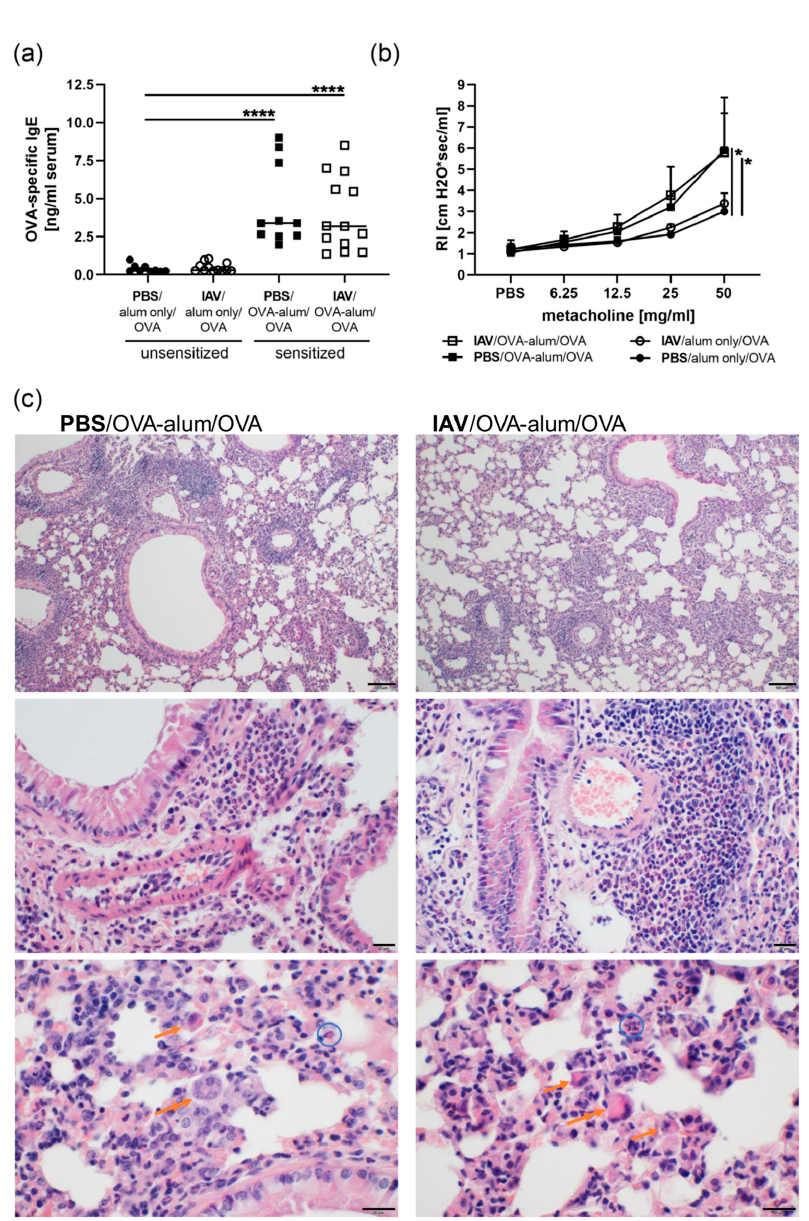
Figure 4. Resolved IAV infection does not affect IgE production and airway hyperreactivity but affects histological changes in AAI. Mice were infected i.n. with a sublethal dose of IAV or treated with PBS on day 0, were sensitized against OVA i.p or mock-sensitized with alum only i.p. on days 14, 21 and 28 and all mice were challenged i.n. with OVA on days 35, 36 and 37. On day 39 post infection, OVA-specific IgE levels in the serum ( a ), airway hyperreactivity in terms of lung resistance (RI) in response to metacholine ( b ) and histological changes in hematoxylin and eosin stained lung tissue ( c ) were analyzed. In ( a ), data are shown for individual mice compiled from three independent experiments together with the group median. In ( b ) the mean + SD of n = 4 control mice (PBS/alum only/OVA) and n ≥ 5 IAV infected only (IAV/alum only/OVA), sensitized only (PBS/OVA-alum/OVA) or IAV infected and sensitized mice (IAV/OVA-alum/OVA) compiled from two independent experiments are shown. p -values in ( b ) refer to RI following administration of 50 mg/mL metacholine. In ( c ), representative images for one out of 5 analyzed mice / group are shown. The upper images were prepared at 100 × magnification (scale bar 100 µ m), the images of the middle panel at 400 × magnification (scale bar 20 µ m) and the lower panel at 600 × magnification (scale bar 20 µ m). Orange single arrows point at alveolar histiocytosis, double arrows at multinucleated macrophages and blue circles at eosinophils. * p < 0.05, **** p <